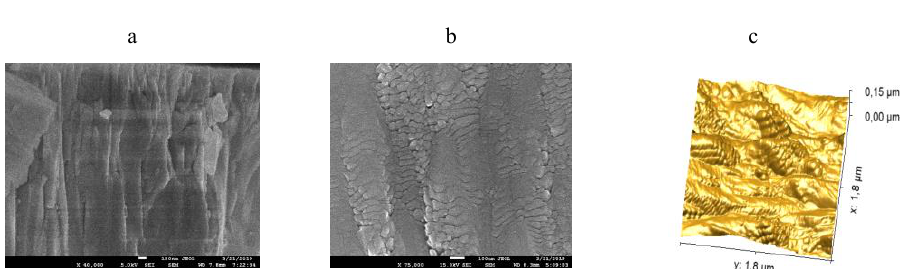
Fig. 1. SEM-image of the cross-section (a) and the surface (b) of the M-coating on the substrate of the WRe-27 plate. AFM image of the M-coating surface on a Si plate (c). The working pressure of the gas mixture Xe + CO 2 — 0.11- 0.13